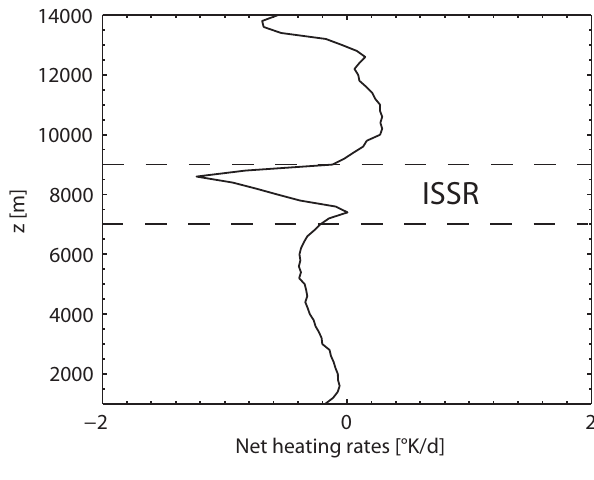
Fig. 1. Heating-rates [K/d] of an ISSR with RHi=130% due to emis- sion and absorption of